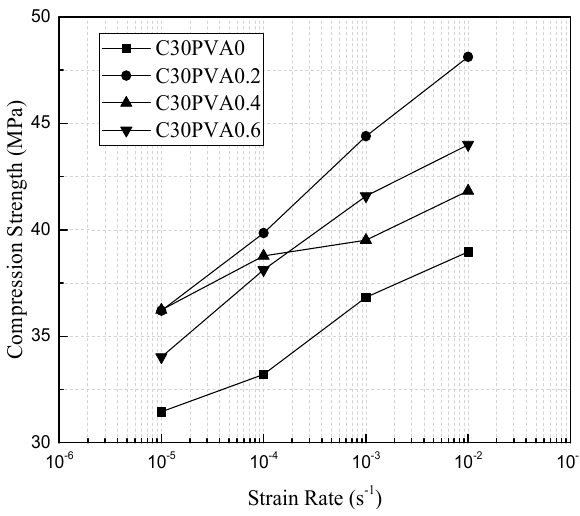
Figure 3. Uniaxial compressive strength of FRC (C30).